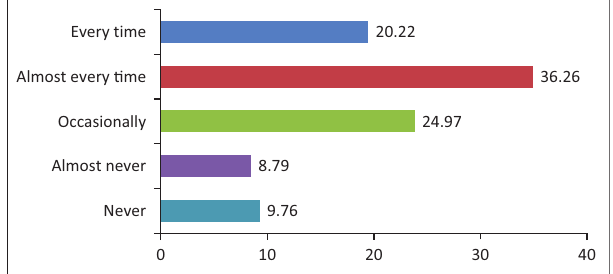
FIGURE 5: Establishment of organisational responsibility in municipal employees’ roles in relation to completing a task.